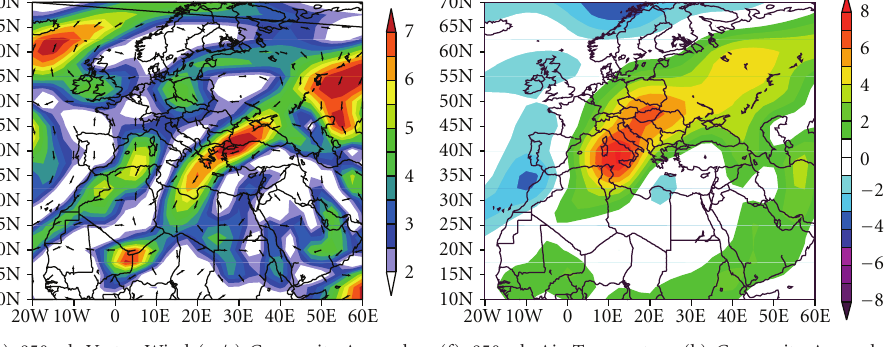
Figure 2: Meteorological fields from NCEP/NCAR Reanalysis. The anomalies are evaluated on the climatology 1981 − 2010. (a) Sea level pressure anomaly for 10 − 21 June 2006, (b) 850 mb wind vector anomaly for 10 − 21 June 2006, (c) mean sea level pressure for 25 − 29 June 2006, (d) sea level pressure anomaly for 25 − 29 June 2006, (e) 850 mb wind vector anomaly for 25–29 June 2006, and (f) 850 mb air temperature anomaly for 25 − 29 June